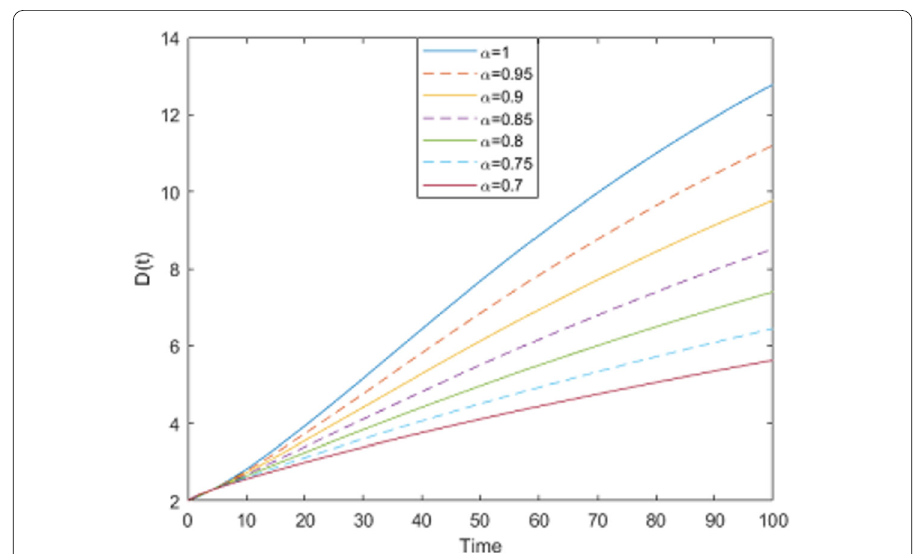
Figure 13 The class of researchers that die, retire, or leave fractional calculus